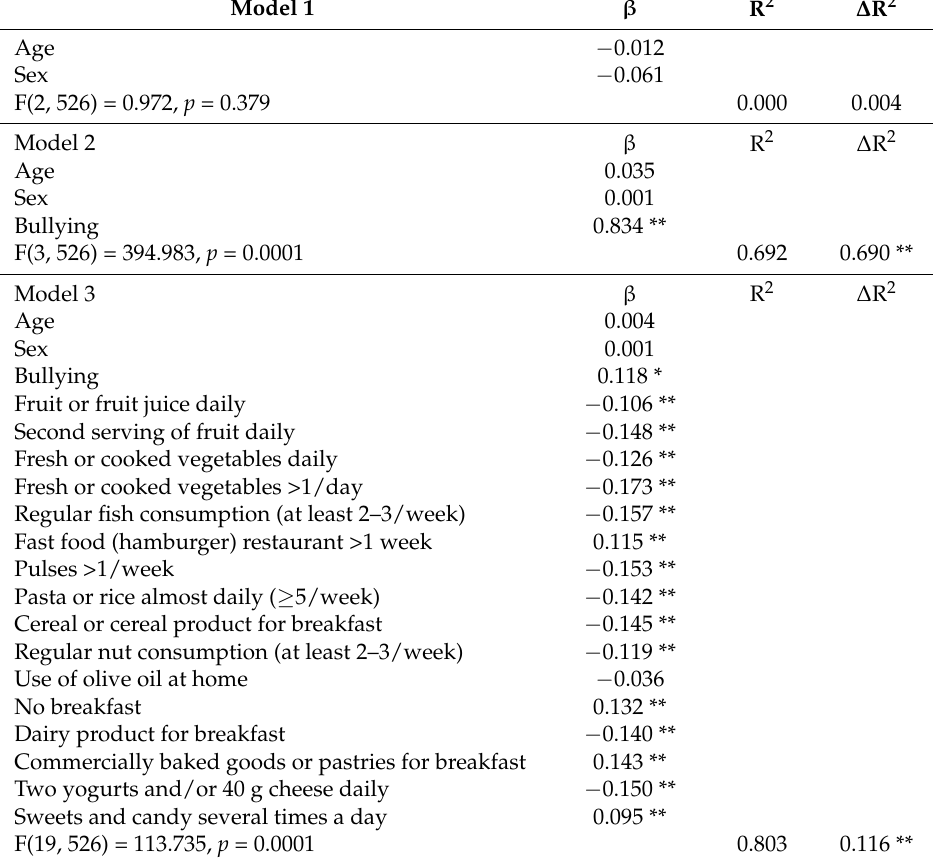
Table 3. Predictive values of age, sex, bullying, and dietary habits in depression (* p < 0.05; ** p <